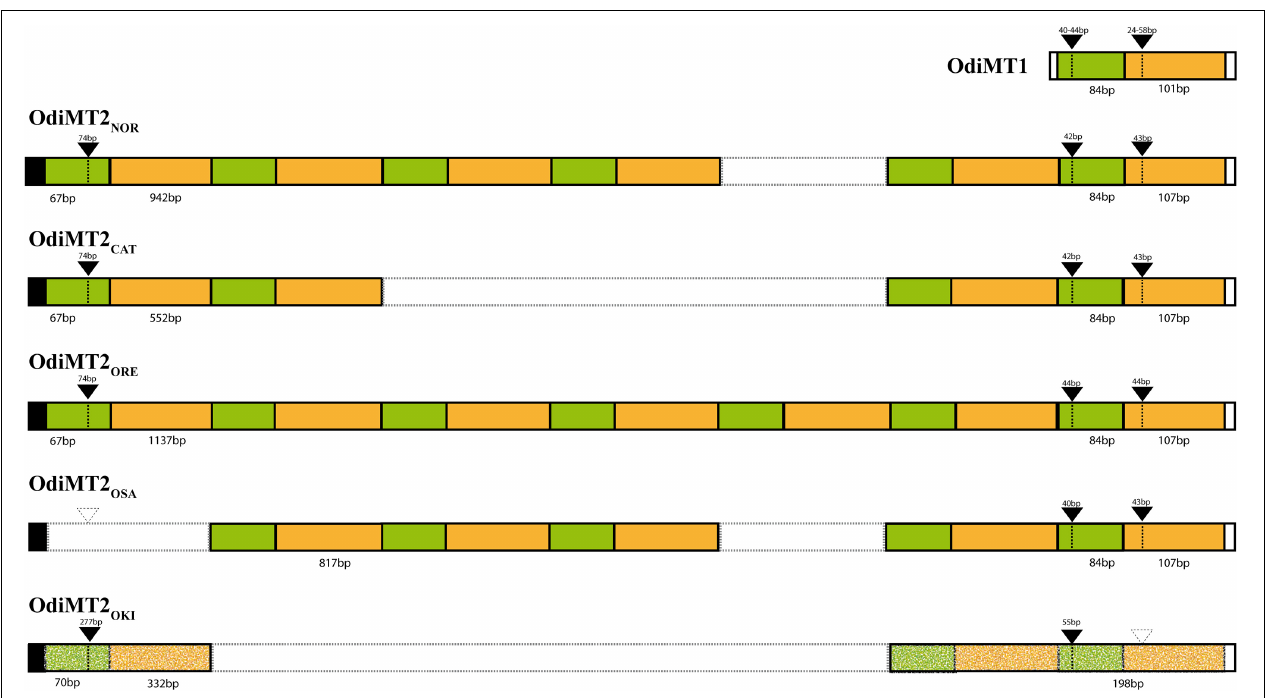
a For the calculation of sequence identities, a gap between two sequences has been considered as a single difference.